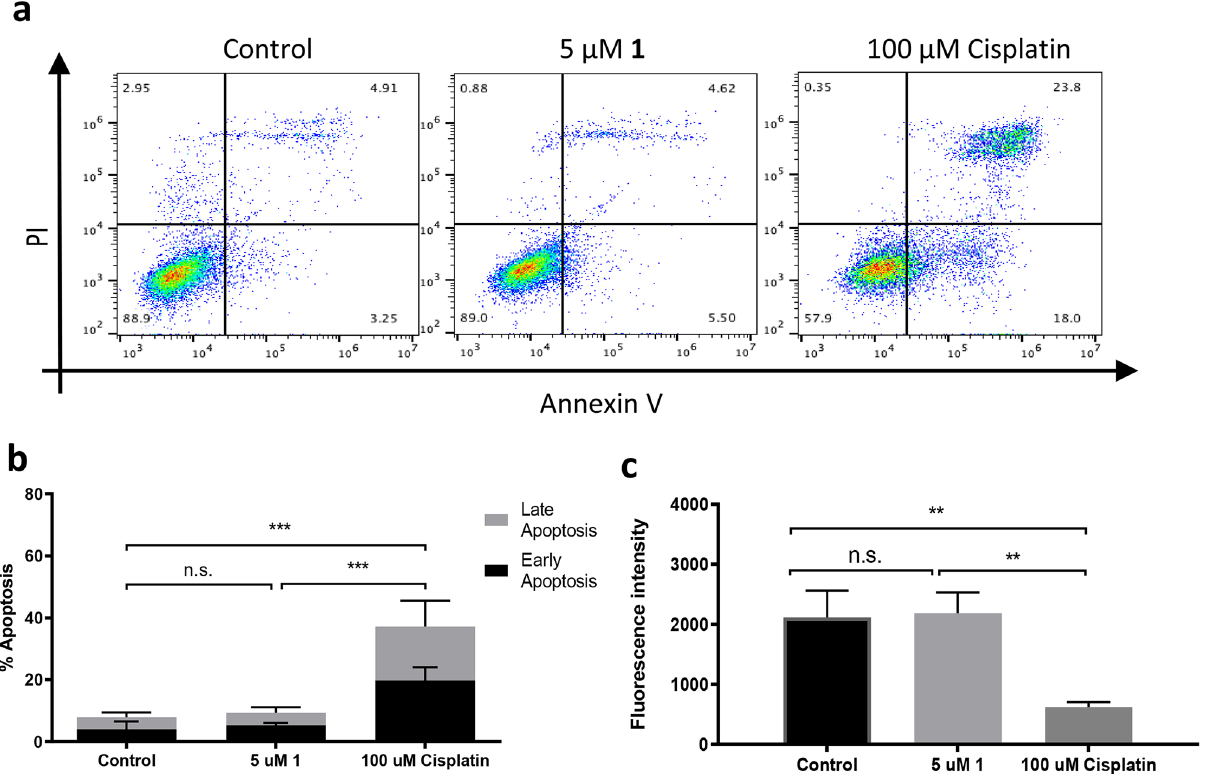
Figure 5. Analysis of compound 1 toxicity in SCC-9 cells. ( a ) A representative dotplot of flow cytometric analysis of cell toxicity of 1 analysed by FlowJo Software 22 . After 24 h of treatment with compound 1 or positive control (Cisplatin), cells were harvested, stained with Annexin V-FITC and propidium iodide, and analysed by flow cytometry. ( b ) Quantitation of apoptotic levels after treatment; means ± SD, n = 3. Two-way ANOVA, *** p < 0.001, n.s. not significant. ( c ) Viability of SCC-9 cells after 24 h treatment with 1, assessed by Alamar Blue assay. Means ± SD, n = 3. Student t test, ** p < 0.01, n.s. not significant. Graphs were plotted using GraphPad version 6.0c for Mac, www. graph pad.